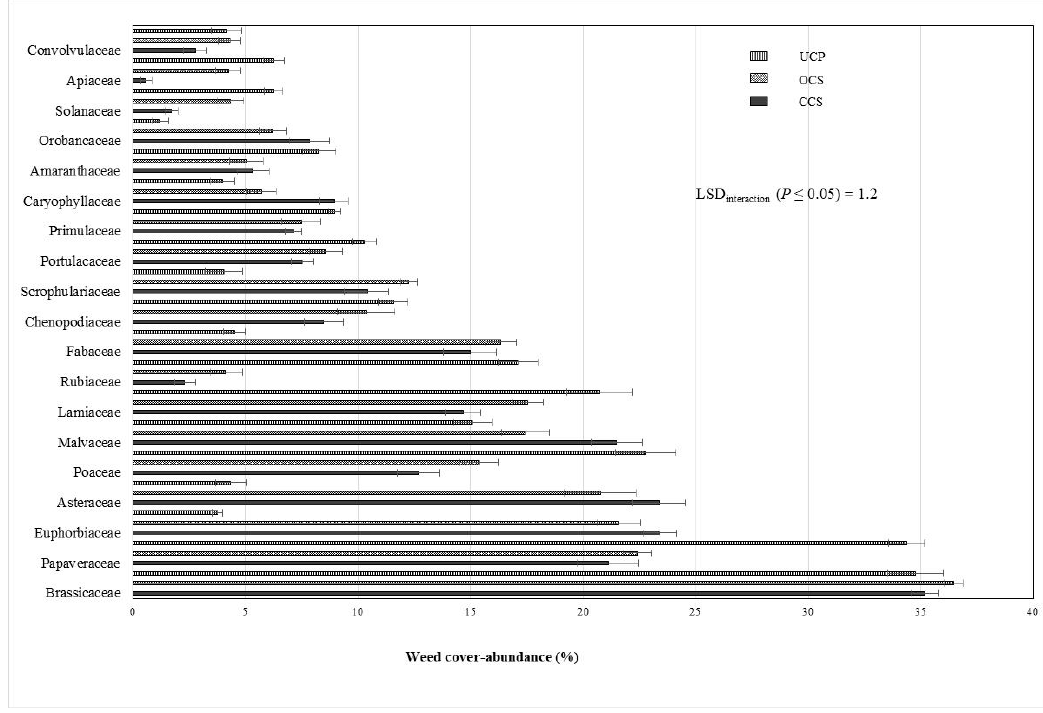
Figure 4. Percentage of weed cover-abundance as affected by the ‘botanical family × cultivation system’ interaction.